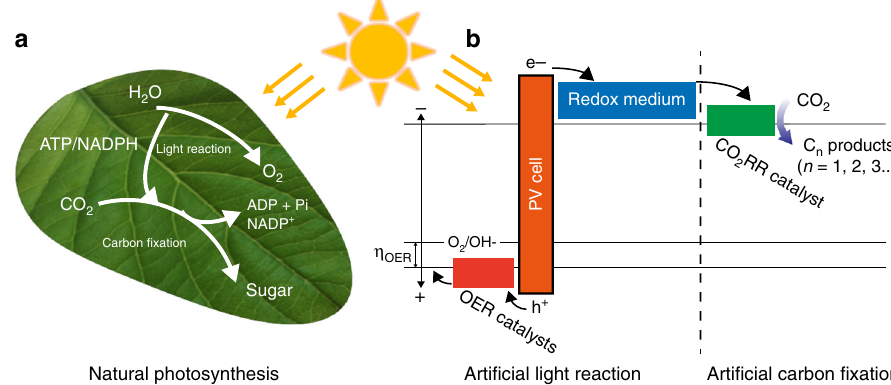
Fig. 1 Schematic illustration of the redox-medium-assisted CO 2 electroreduction system consisting of both light reaction and (dark) carbon fi xation. a Reaction pathway of natural photosynthesis. b Energy diagram of each part in the redox-medium-assisted